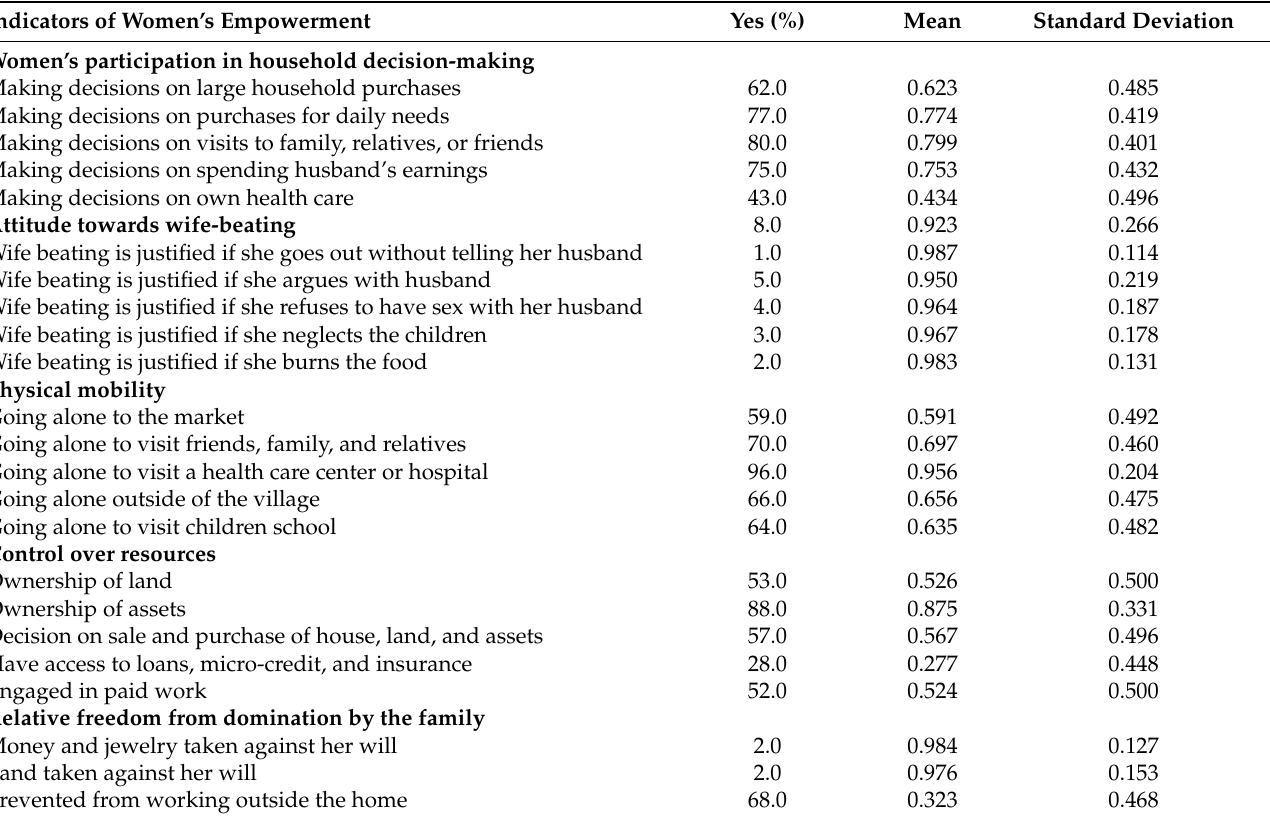
Table 3. Descriptive statistics of women’s empowerment.